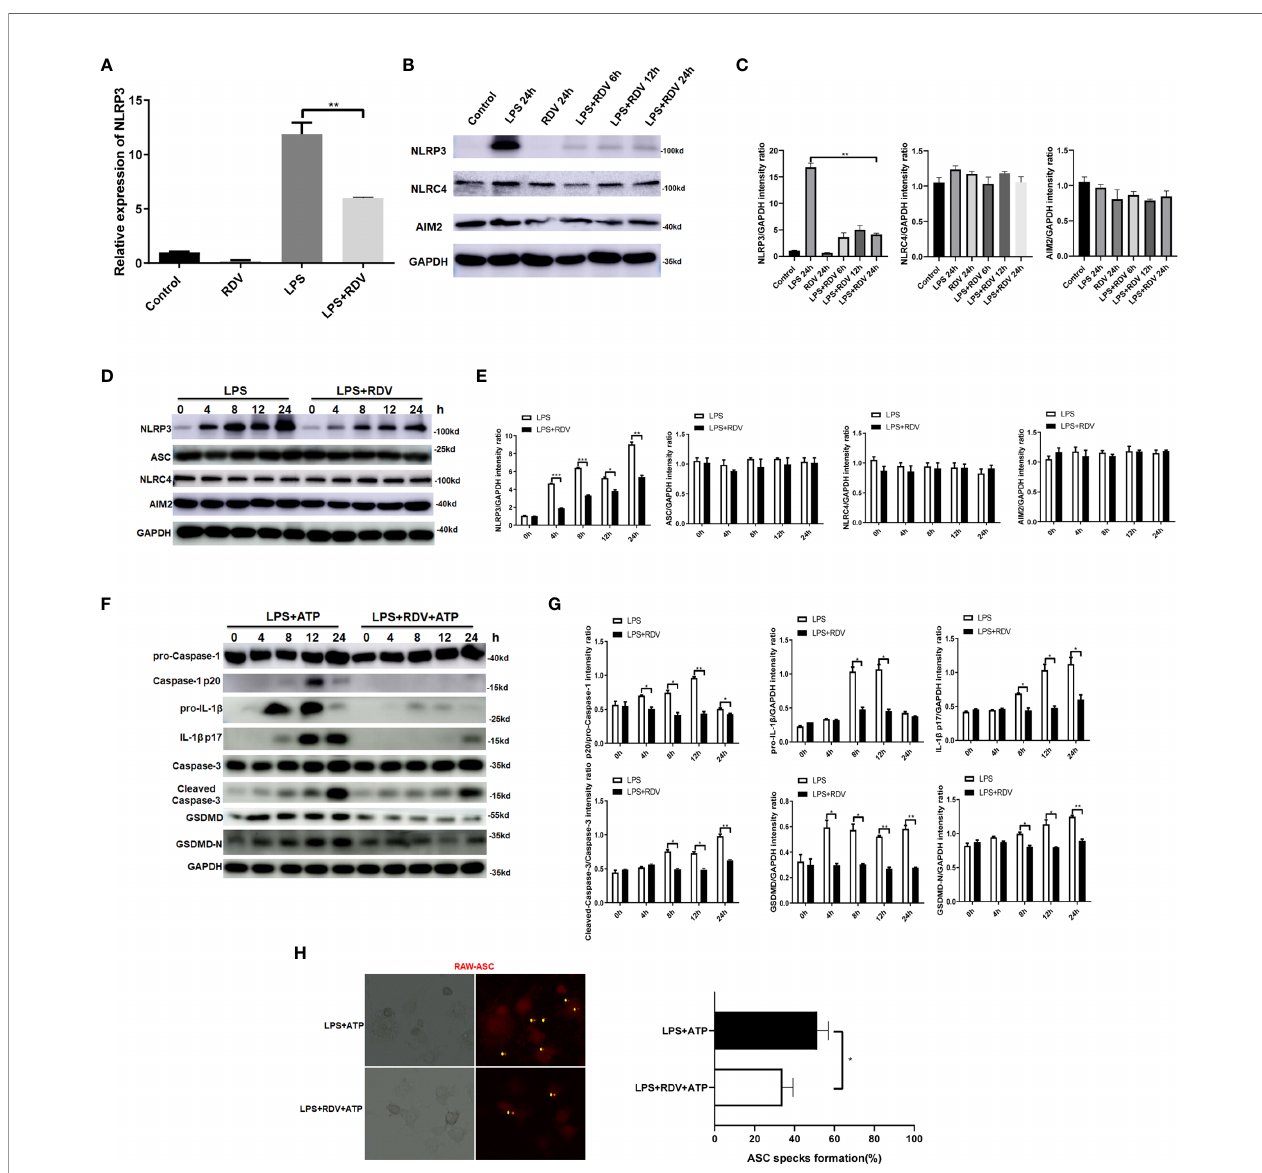
FIGURE 1 | RDV inhibits the activation of NLRP3 in fl ammasome. (A) RT-PCR analysis of NLRP3 mRNA expression in mouse peritoneal macrophages stimulated with LPS, RDV, and LPS + RDV for 12 h. (B) Western blot analysis of NLRP3, NLRC4 and AIM2 in mouse peritoneal macrophages under LPS, RDV and LPS+RDV stimulation. (C) Relative intensity analysis of NLRP3, NLRC4 and AIM2. (D) Western blot analysis of NLRP3, ASC, NLRC4, AIM2 in mouse peritoneal macrophages under LPS and LPS+RDV stimulation at different time points. (E) Relative intensity analysis of NLRP3, ASC, NLRC4 and AIM2. (F) Western blot analysis of pro-Capase-1, Caspase-1, pro-IL-1 b , IL-1 b , Caspase-3, Cleaved-Capase-3, GSDMD, GSDMD-N. (G) Relative intensity analysis of Caspase-1/pro-Capase-1, pro-IL-1 b /GAPDH, IL-1 b / GAPDH, Cleaved-Capase-3/Caspase-3, GSDMD/GAPDH, GSDMD-N/GAPDH. (H) ASC specks formation assay of the effect of LPS and LPS + RDV stimulation for 12 h and treatment with ATP in the last 40 min. Percentages of ASC speck formation marked on the images. Data are representative as mean values ± SD from three independent experiments. *P < 0.05; **P < 0.01; ***P <